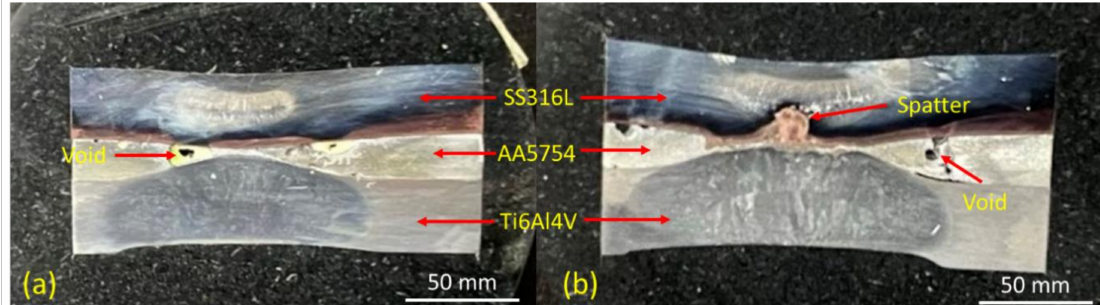
Figure 6. The cross-sectional cut appearance of the welded samples: ( a ) Sample 1-High Tensile-Shear Load; ( b ) Sample 3-High